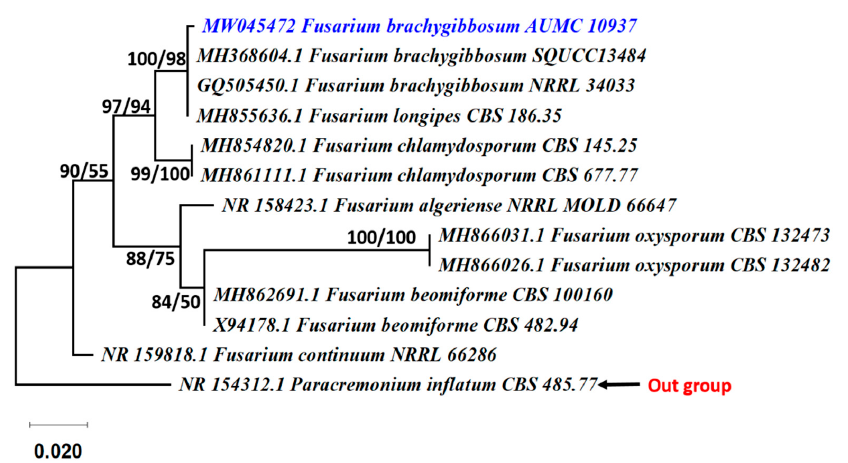
Figure 2. Phylogenetic tree generated from MP analysis based on ITS sequence data of Aspergillus stelliformis AUMC 10920 and A. sydowii AUMC 10935 associated to other related genes in Aspergil- laceae. Blue color refers to the species in this study. Bootstrap support values (100 replications) for ML/MP combination equal to or greater than 50% are indicated at the respective nodes. The tree is rooted to Aspergillus awamori -CBS 557.65 as the out group.